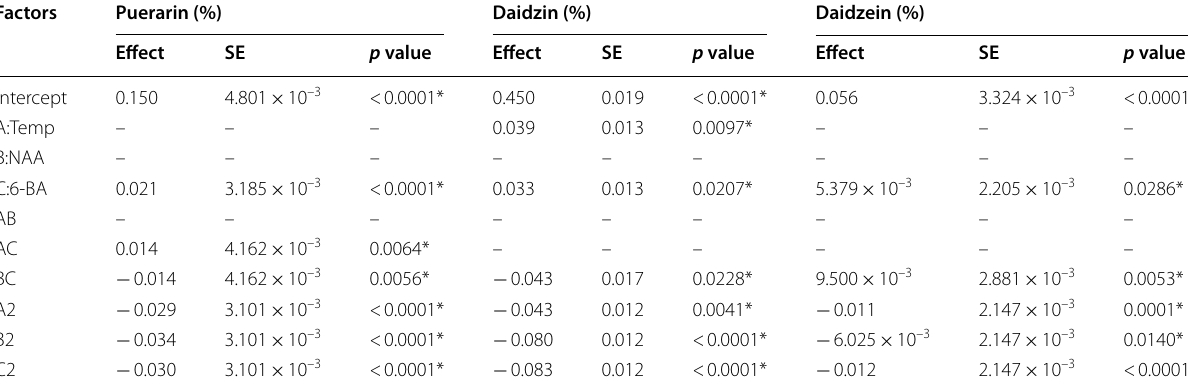
Table 3 Estimated effects for temperature, 6-BA and NAA concentration on production of puerarin, daidzin, and daidzein